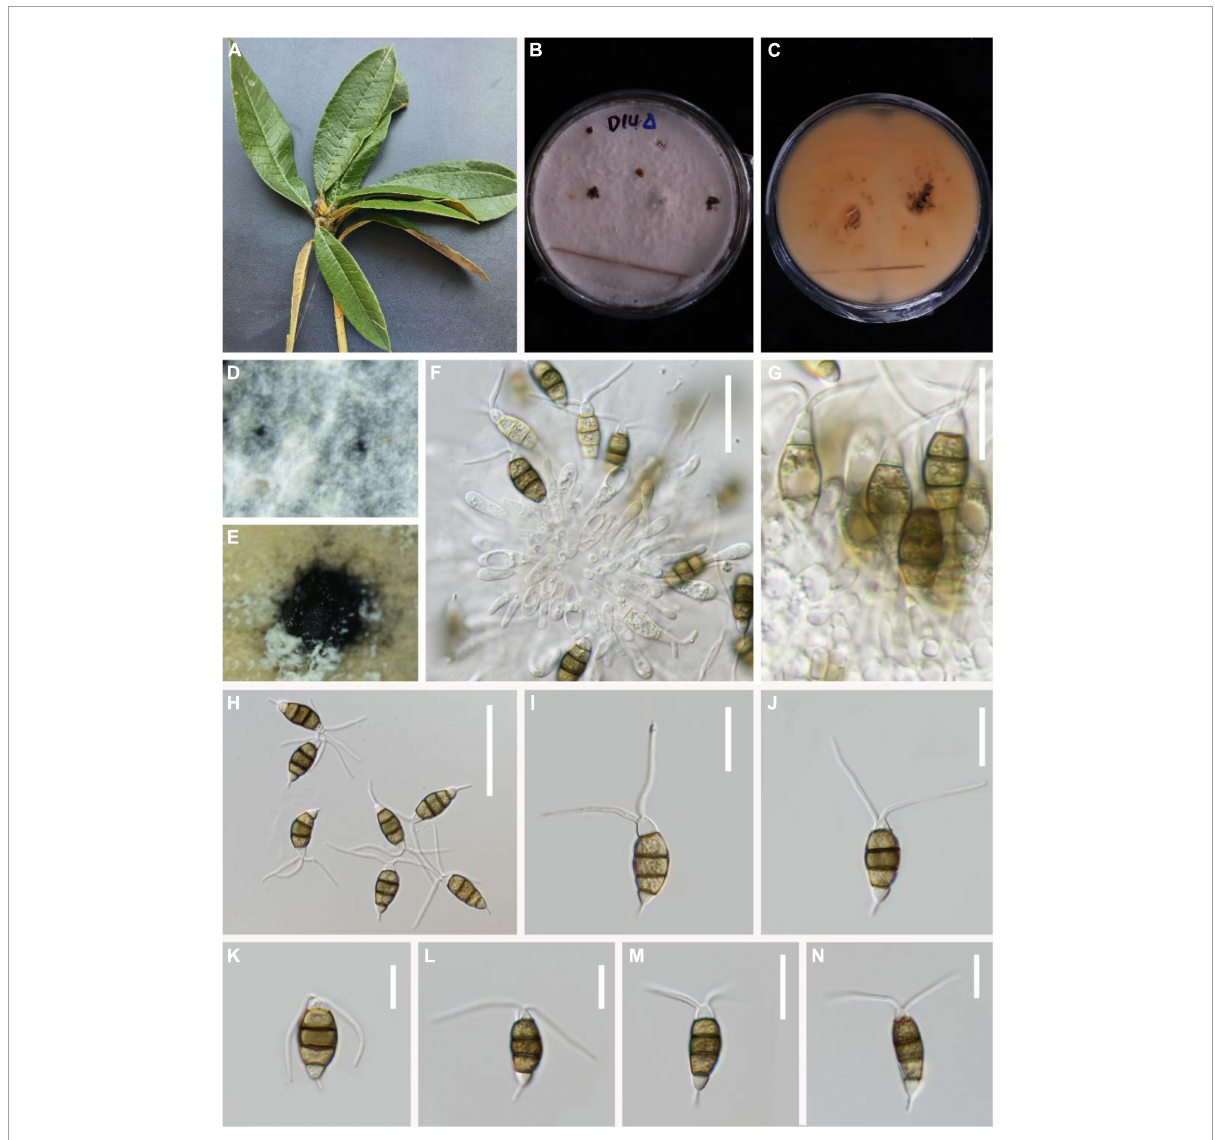
FIGURE7 Pestalotiopsis suae (KUN-HKAS 124578, holotype). (A) Leaves of Rhododendron delavayi . (B,C) Culture on potato dextrose agar (PDA) (upper and lower view). (D,E) Conidiomata on PDA. (F,G) Conidiophores, conidiogenous cells, and conidia. (H–N) Conidia with appendages. Scale